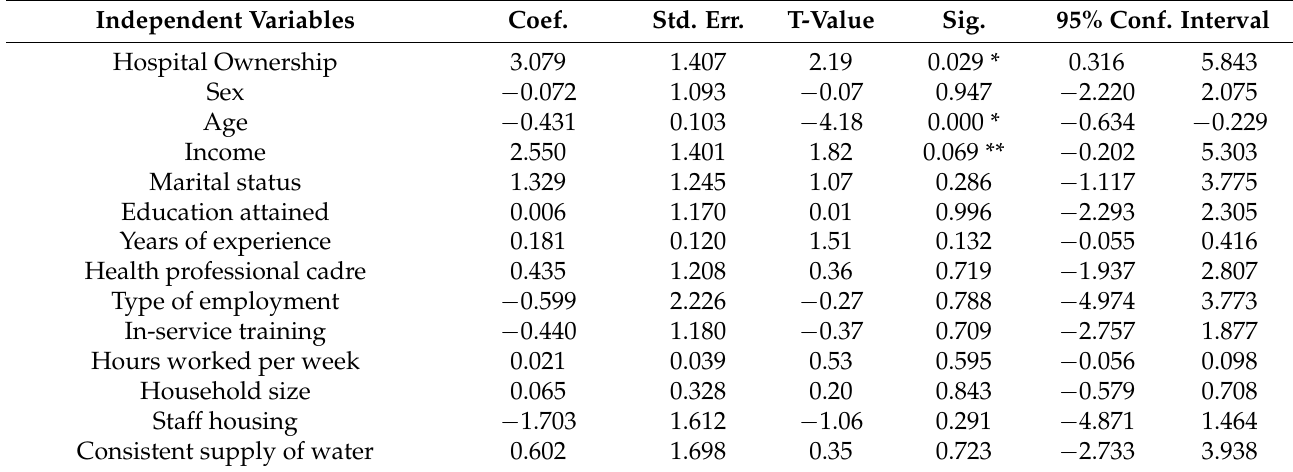
Table 5. Results of linear multivariate regression of overall health status, and independent variables ( n = 553). Independent